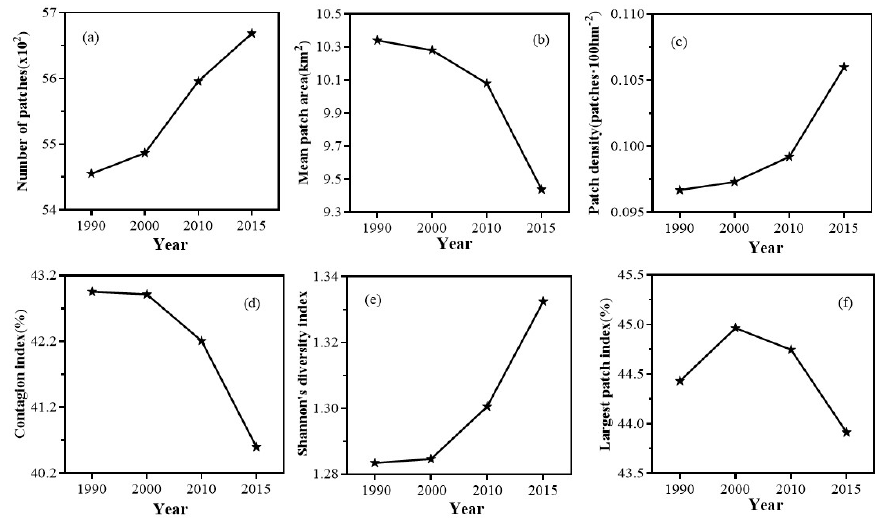
Figure 6. Landscape metrics in the MRYRR from 1990 to 2015. ( a ) Number of patches from 1990 to 2015. ( b ) Mean patch area from 1990 to 2015. ( c ) Patch density patches from 1990 to 2015. ( d ) Contagion index from 1990 to 2015. ( e ) Shannon’s diversity index from 1990 to 2015. ( f ) Largest patch index from 1990 to 2015.